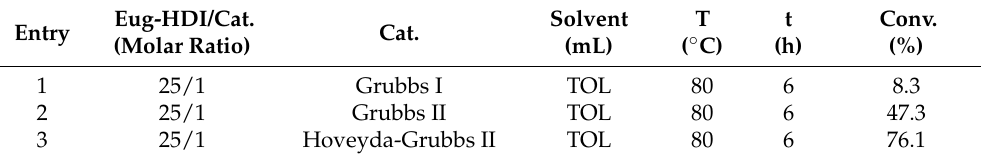
Table 1. Eug-HDI olefin metathesis under different catalysts.